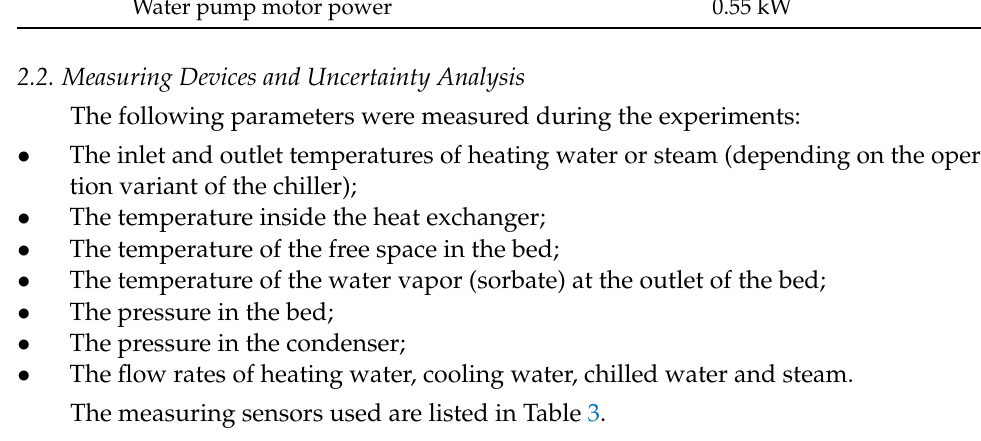
Table 3. Technical parameters of measuring